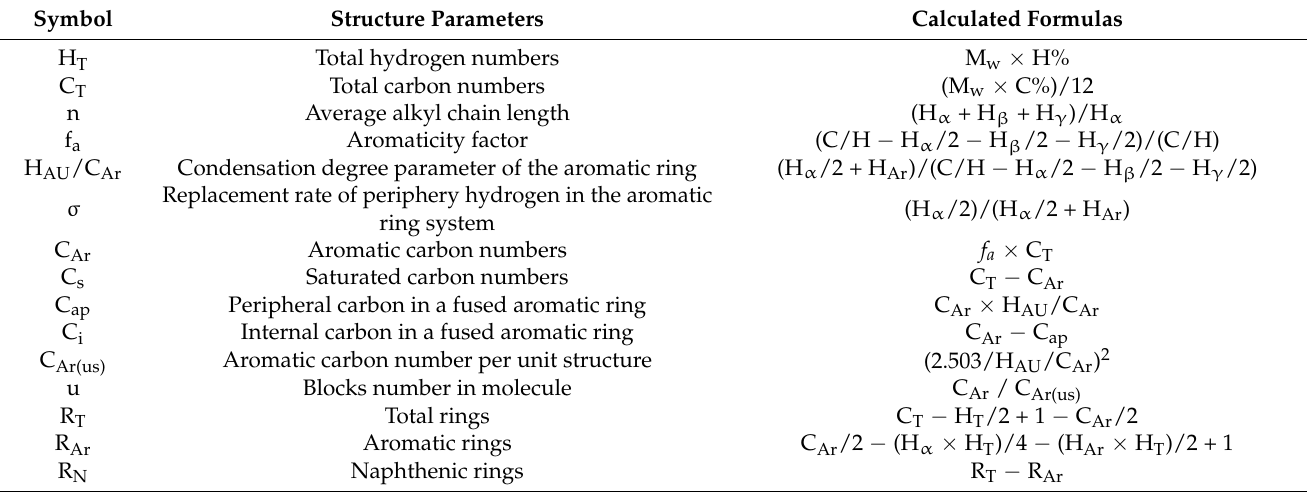
Table 6. Calculated formulas for the asphaltene structural parameters